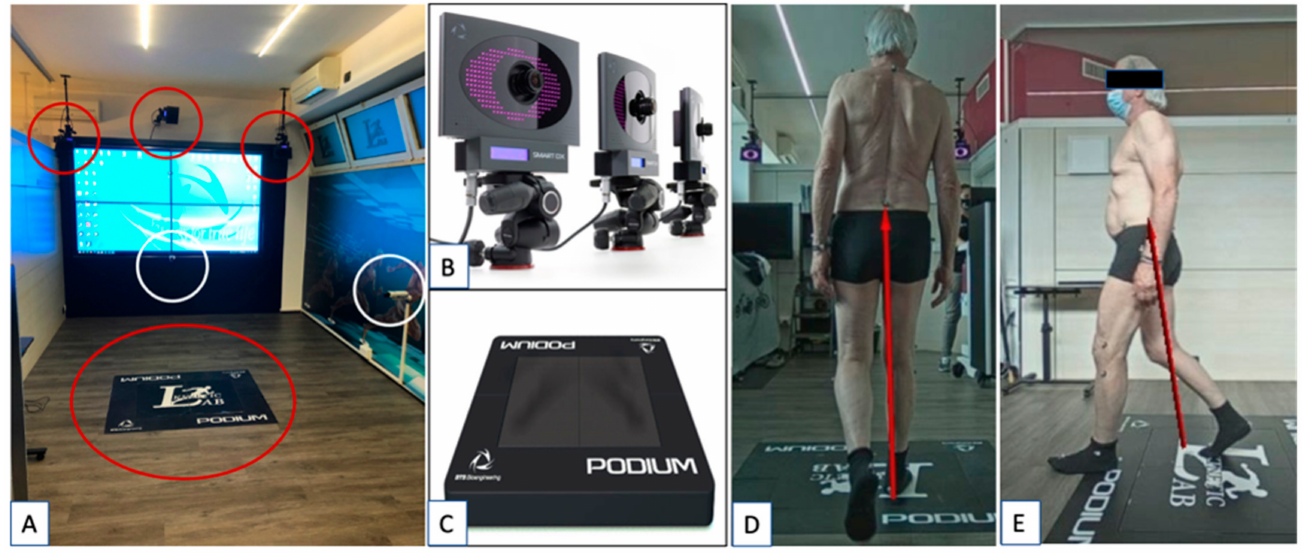
Figure 2. ( A ) The gait lab set-up at the Kinetic Center (Pisa, Pi, Italy) with the infra-red cameras and the two Podium force platforms—red circles; ( B ) details of optoelectronic infra-red cameras capable of detecting the reflecting markers on to the patients; ( C ) details of one Podium platform used to measure the GFR during a patient’s walk. The cameras, the platforms and the data software employed were provided by BTS Bioengineering (Garbagnate Milanese, Mi, Italy). In ( D , E ), a patient performs a test in the gait lab: one can notice the markers placed on the patient according to Helen Heyes Medial Marker protocol and the GFR (red vectors). The GFR vectors can be identified by the cameras in white circles in A when the patient engages one of the two Podium force